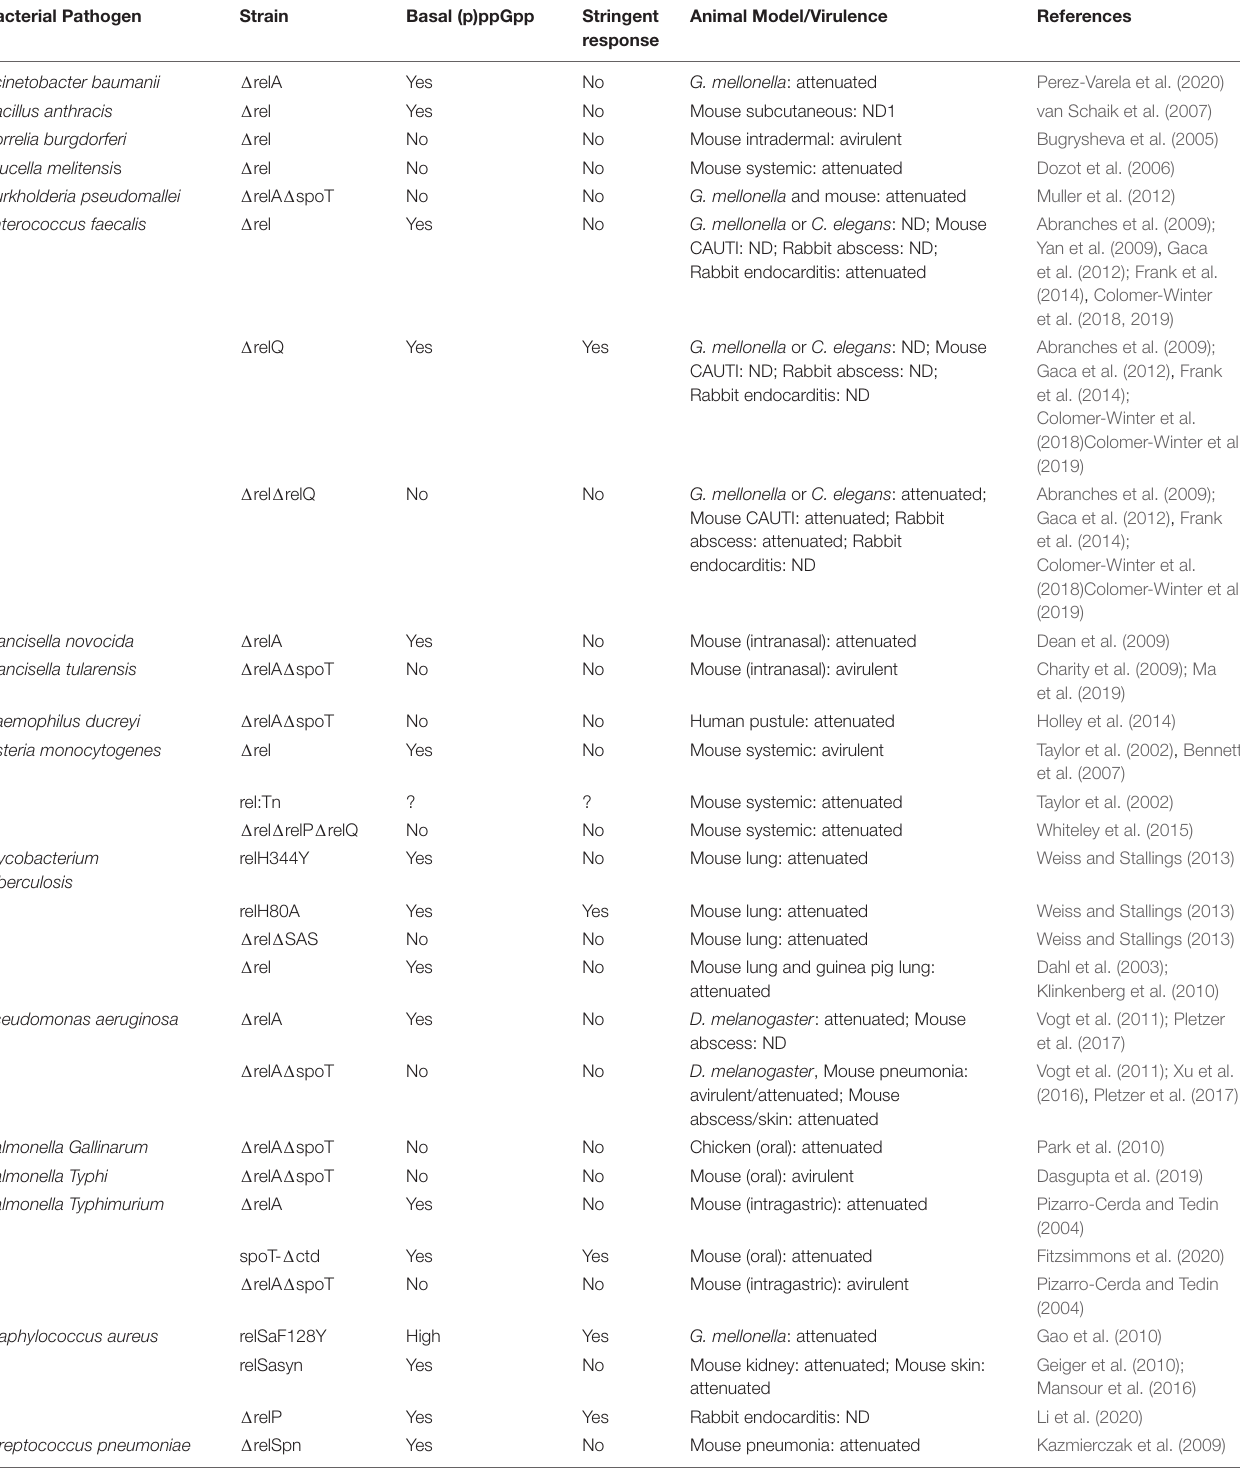
Mouse kidney: attenuated; Mouse skin: attenuated Mouse pneumonia: